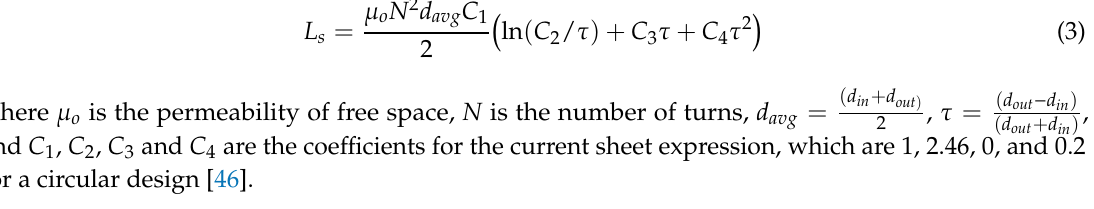
Figure 2. Geometrical representation of the proposed LC system: ( a ) LC sensor with a capacitor of the radius ( 𝑟 ) and planar inductor with an inner diameter ( 𝑑 (cid:3036)(cid:3041) ) shown with a solid line, outer diameter ( 𝑑 (cid:3042)(cid:3048)(cid:3047) ) shown with a dotted line, trace separation ( 𝑠 ) and trace width ( 𝑤 ); ( b ) Reader antenna with the same design parameters ( 𝑑 (cid:3036)(cid:3041) , 𝑑 (cid:3042)(cid:3048)(cid:3047) , 𝑠 , 𝑤 ).